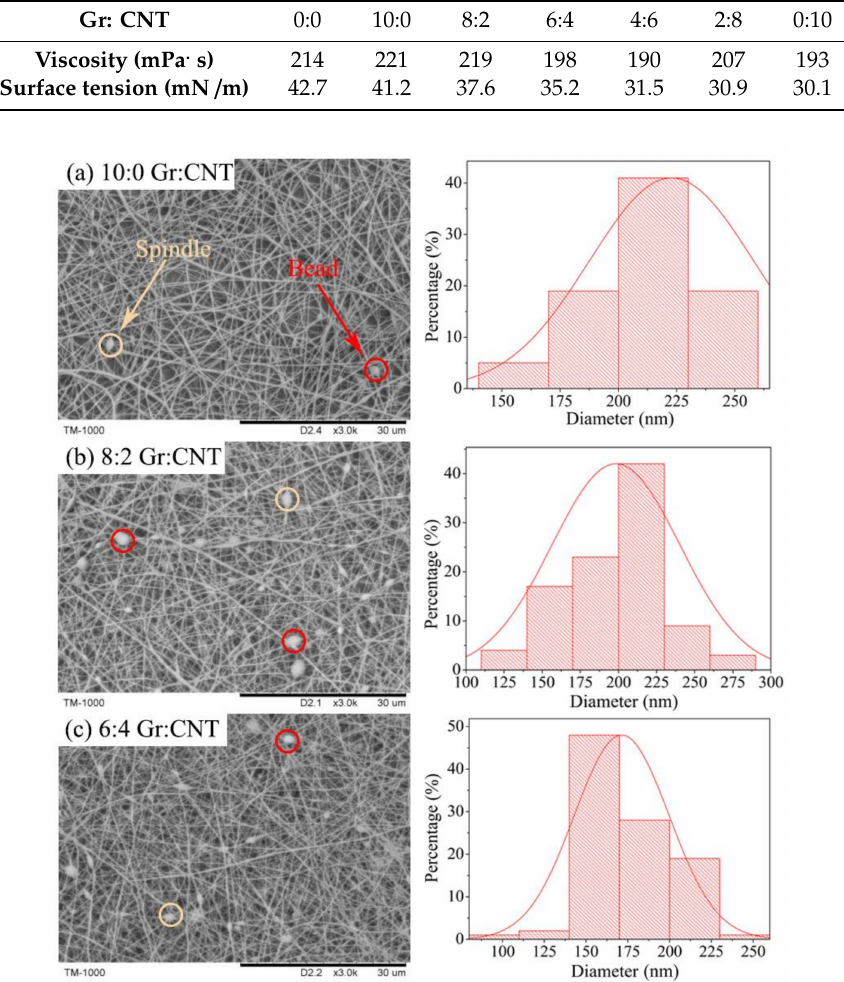
Table 1. Viscosity and surface tension of spinning